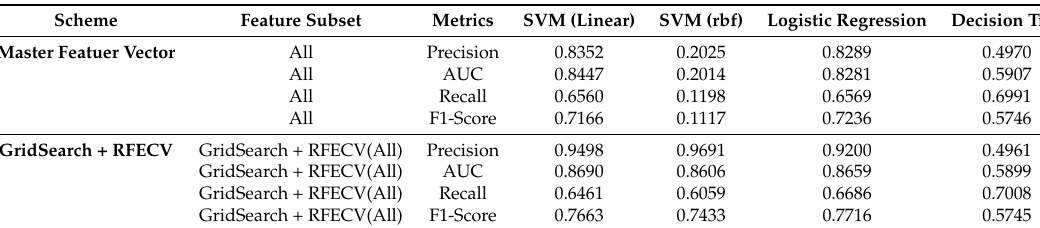
Table 3. Results of all features subsets selected by GridSearch-based RFECV features selection scheme using well known ML classifiers with 10-fold cross validation.